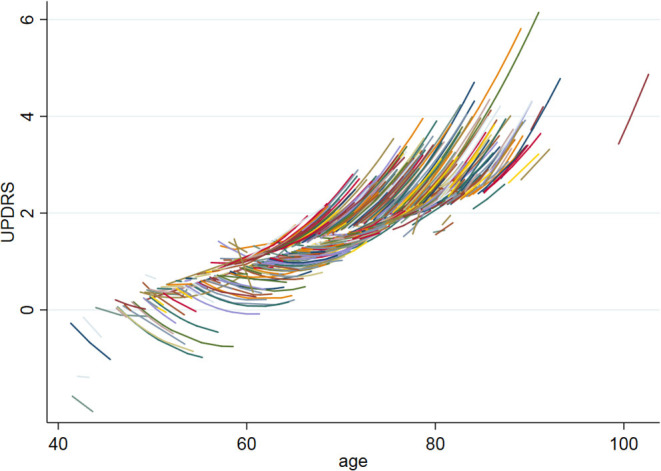
UPDRS baseline age by time interaction. The figure shows the UPDRS baseline age by time interaction, such that the slope of UPDRS scores was negative in adults <60 years old and became significantly more positive with subsequent increasing age (baseline age*time: b = 0.009, p = 0.03).